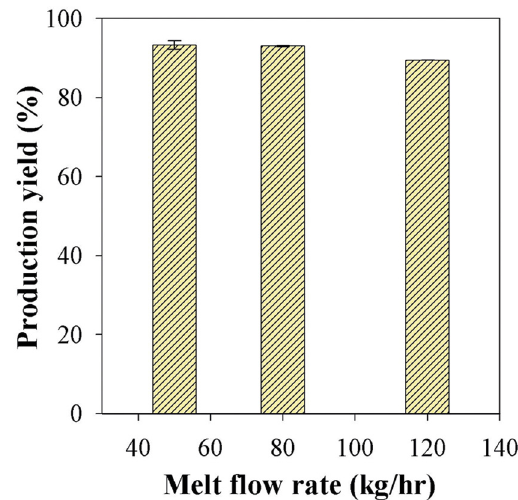
Figure 10. Effect of melt flow rate on production yield of zinc powder, with 30,000 rpm rotating speed, 60 mm diameter disc, and 550 o C melt temperature.